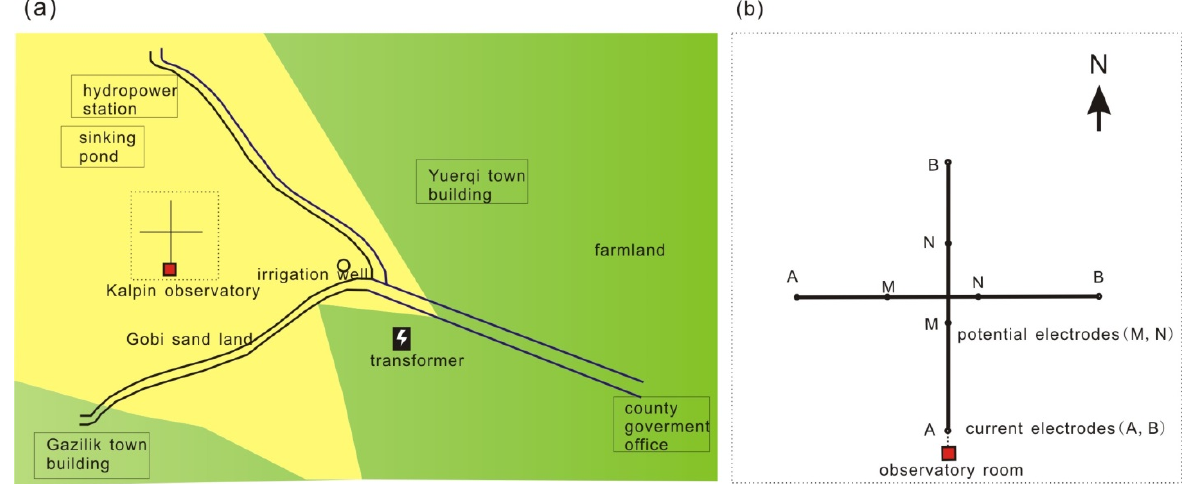
Figure 2. Illustration of the ( a ) Schlumberger array employed at the Kalpin Geoelectric Resistivity Observatory and the observation environment (the yellow area is part of the Gobi Desert, while the green area represents farmland) and ( b ) the electrode layout employed in the resistivity